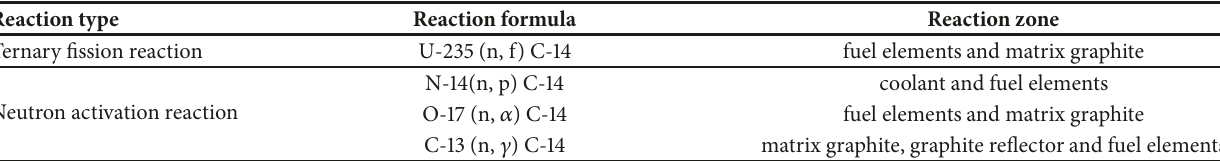
Table 2: C-14 generated in HTR-PM.